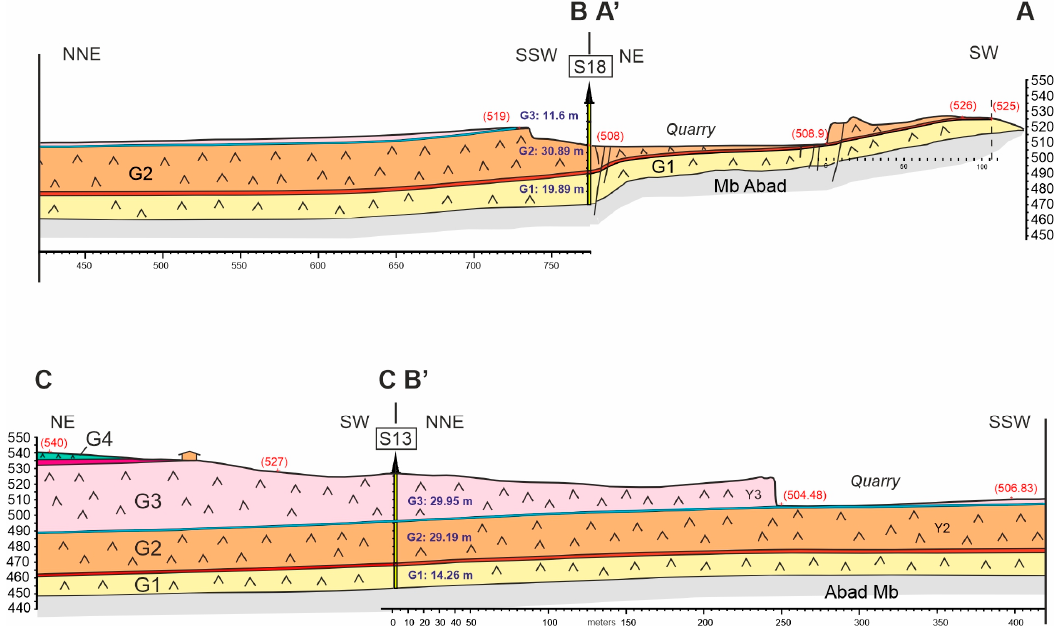
Figure 6. Geological map of the studied area (E sector). The position of the ERT profiles and MASW point are indicated.